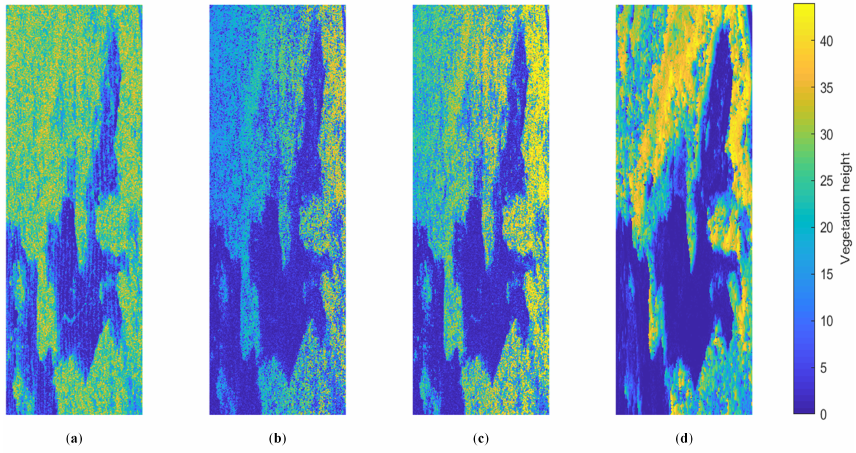
Figure 12. The vegetation height results of ( a ) the RVoG model, ( b ) the RVoG-vtd model, ( c ) the GRVoG-vtd model, and ( d ) LiDAR measurements.